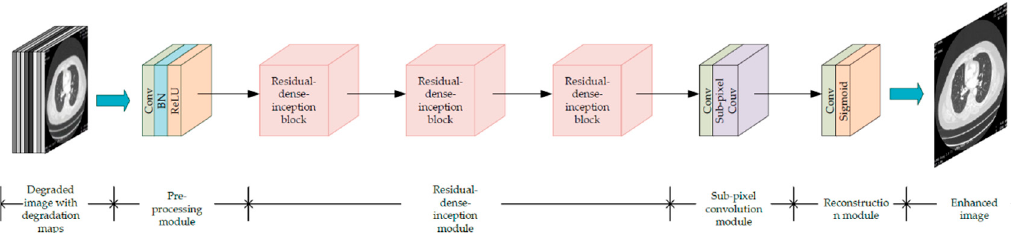
Figure 6. The structure of the proposed residual-dense-inception network for image super-resolution with multiple degradations.